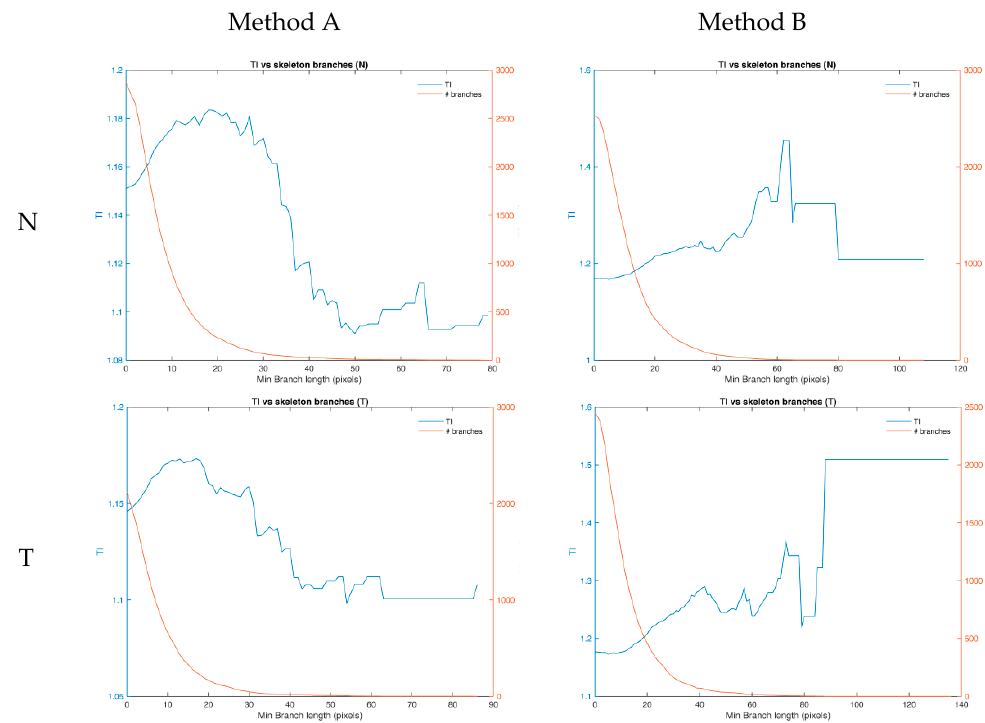
Figure 4. At each abscissa, the two curves represent the values of TI calculated excluding branches shorter than Min Branch length ( blue ), and the number of branches included in the computation ( red ). TI dependence on branch lengths appears to behave similarly in N—Normal and T—Tortuous cases, for the different Methods (A and B shown). Min branch lengths are expressed in pixels.